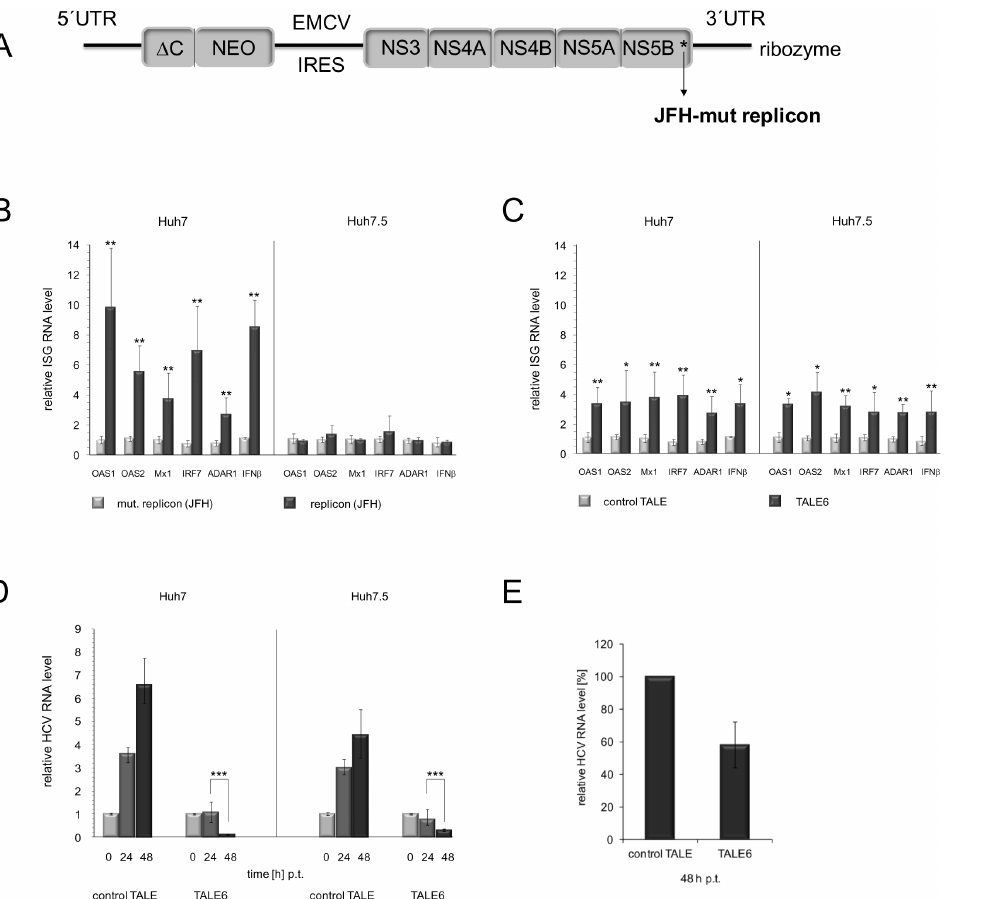
Figure 2. TALE-induced inhibition of HCV RNA replication. (A) Genomic organization of the applied HCV replicon [25]. The untranslated regions (UTRs) and the Encephalomyocarditis virus internal ribosomal entry site (EMCV IRES) are depicted as lines, the regions encoding a part of the core protein ( D C) the neomycine resistance gene and the viral proteins NS3 to NS5B are depicted as boxes. A star in the NS5B coding region indicates that with the non- replicative replicon, this protein was mutated [28]. The replicon RNA was expressed with a 3 9 -ribozyme, which improved the generation of the authentic viral RNA’s 3 9 -end [28]. (B) Induction of IFN-beta and ISGs in Huh7 and Huh7.5 cells that were transfected with the TALE6-encoding plasmid (mRNA level measured with the control TALE in Huh7 and Huh7.5 cells set as 1). The relative mRNA levels of IFN-beta and of the indicated ISGs were determined by qRT-PCR at 24 h p.t. (mRNA level measured with the non-replicative replicon in Huh7 and Huh7.5 set as 1). (C) Analogous experiment performed with cells transfected with a mutant (non-replicative) or replicative HCV replicon. (D) Replication efficiency of HCV replicon in Huh7 and Huh7.5 cells transfected with either TALE6 or control TALE. The relative viral RNA levels were measured at the indicated time points (HCV RNA levels measured at time 0 p.t. set as 1). Error bars indicate standard deviations of five independent experiments (* 5 P , 0,05, ** 5 P , 0,01, *** 5 P , 0,001; set significance level a 5 0,05). (E) Huh7 cells were transfected with HCV replicon RNA. After 6 h, i.e., a time frame where significant HCV replication is detectable by qRT-PCR [14], the cells were transfected with plasmids expressing the control TALE or TALE6. At 48 h post transfection (pt) of the replicon RNA, the relative viral RNA levels were measured (HCV RNA-levels of the control set to 100%). Error bars indicate standard deviations of three independent